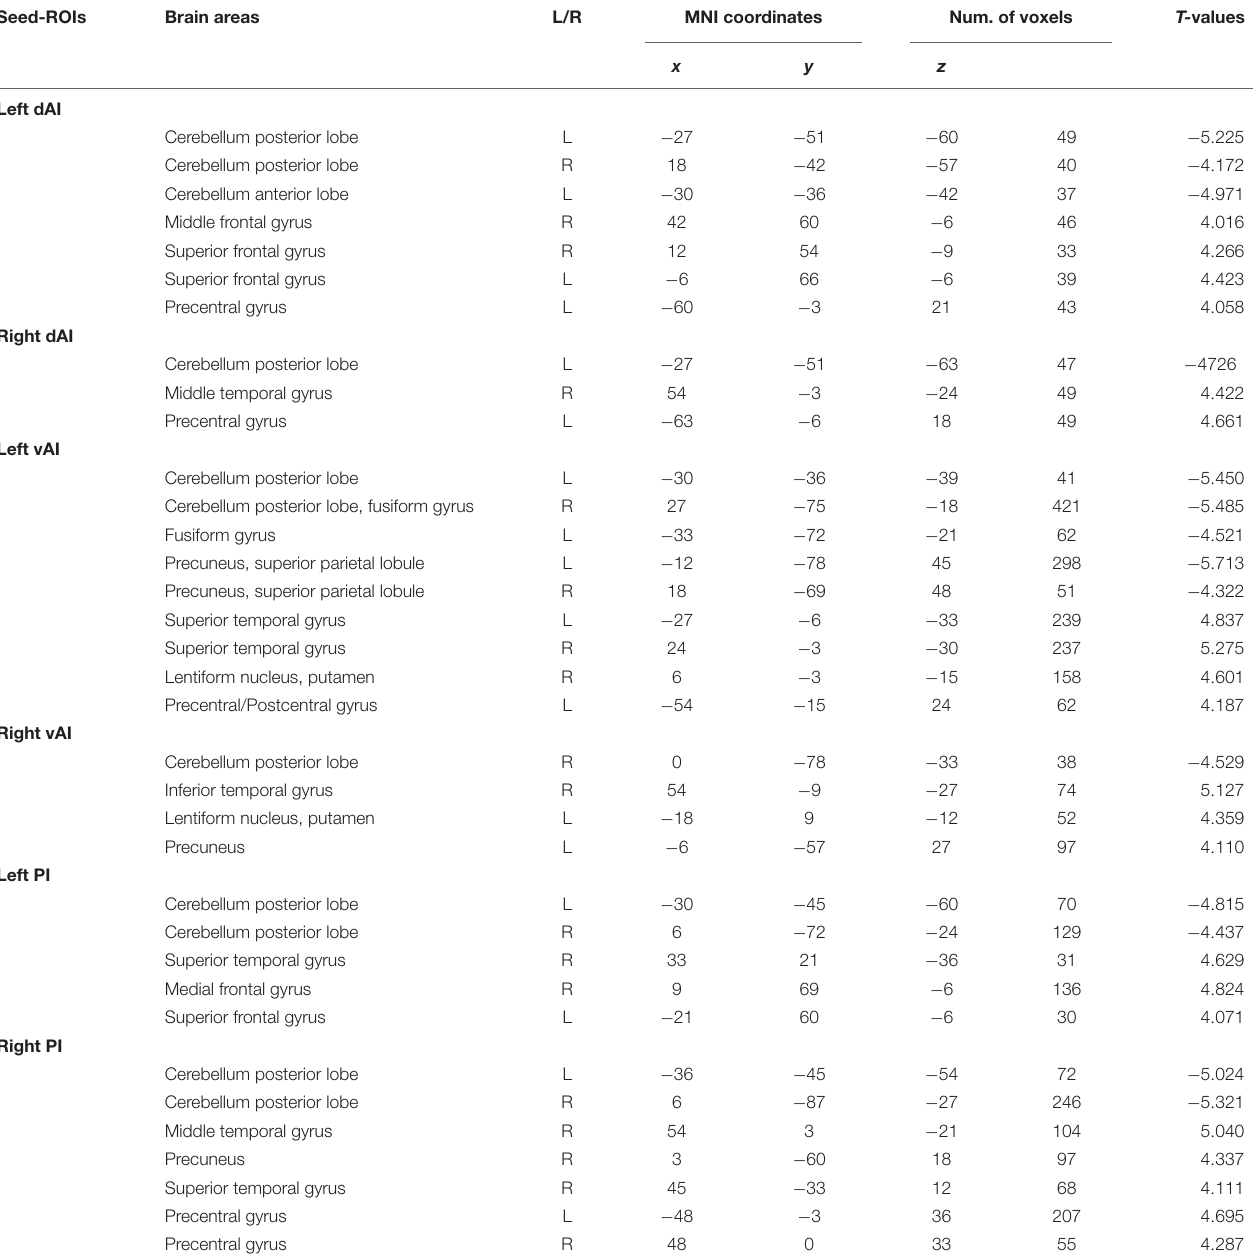
TABLE 2 | Brain areas showing functional connectivity differences with insular subdivisions between OSA patients and HCs. Seed-ROIs Brain areas L/R MNI coordinates Num. of voxels T-